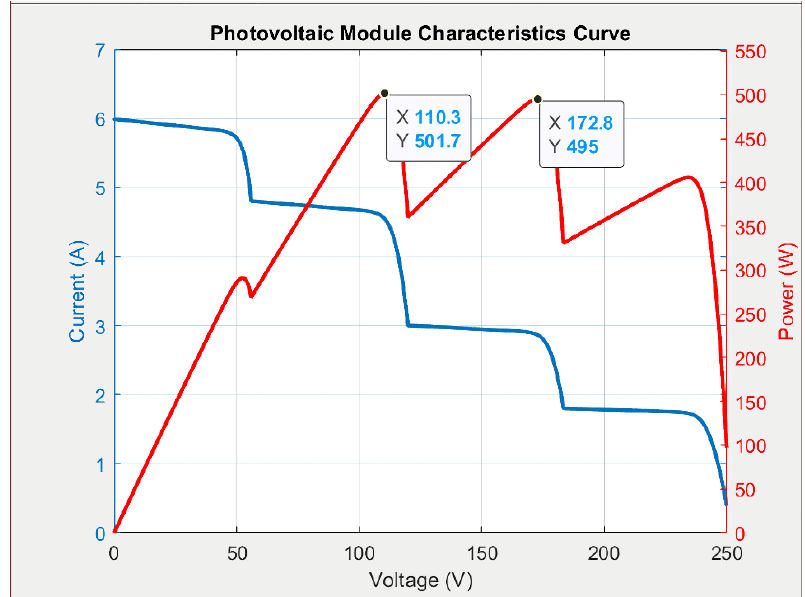
Figure 11. Simulated P–V and I–V characteristic curves for Case 4.